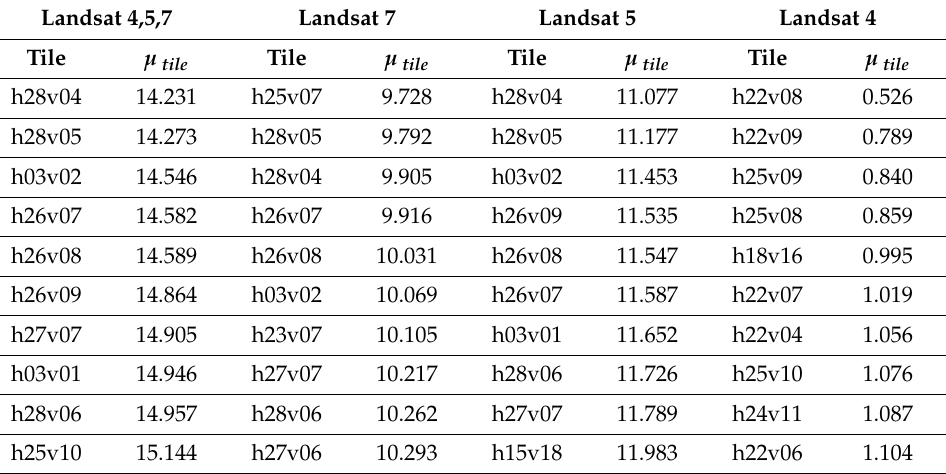
Table 3. The ten least observed CONUS cloud-free ARD tiles over the 36 year study period (white outlined in Figure